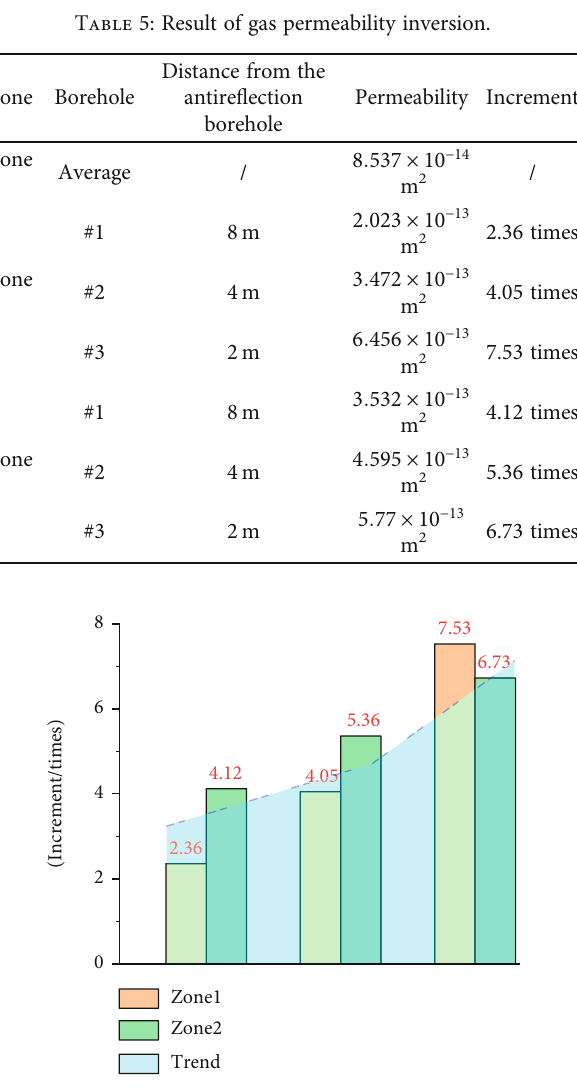
Figure 7: Changes in increment of in situ gas permeability in coal at di ff erent distances.